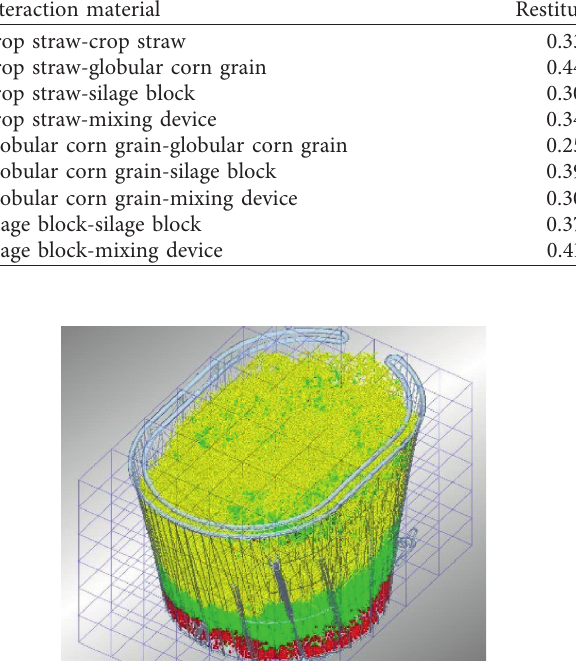
Figure 10: Simulation model of the grid bin. Table 3: Factors and levels of mixing